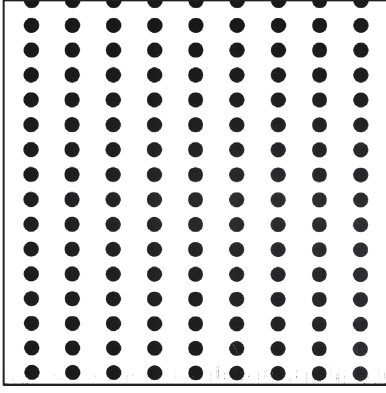
Figure 13. Circle-dot pattern to be